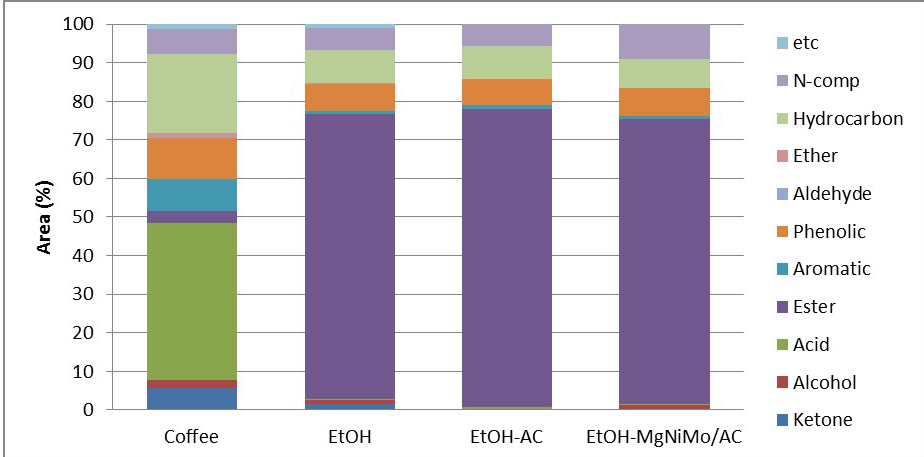
Figure 2. Compositions of coffee biocrude oil and upgraded coffee biocrude oils by GC-MS analysis (reaction conditions: biocrude oil = 20 g, ethanol = 80 g, AC or MgNiMo/AC = 4 g, temperature = 340 ◦ C, reaction time = 2 h, N 2 initial pressure = 30